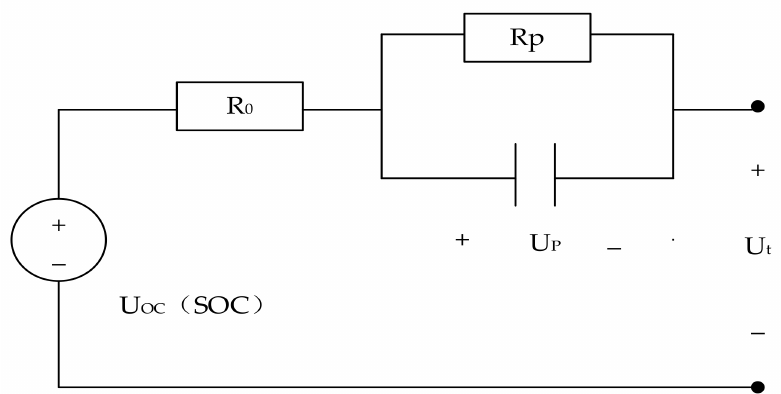
Figure 4. The schematic diagram of Thevenin equivalent circuit of LIB.